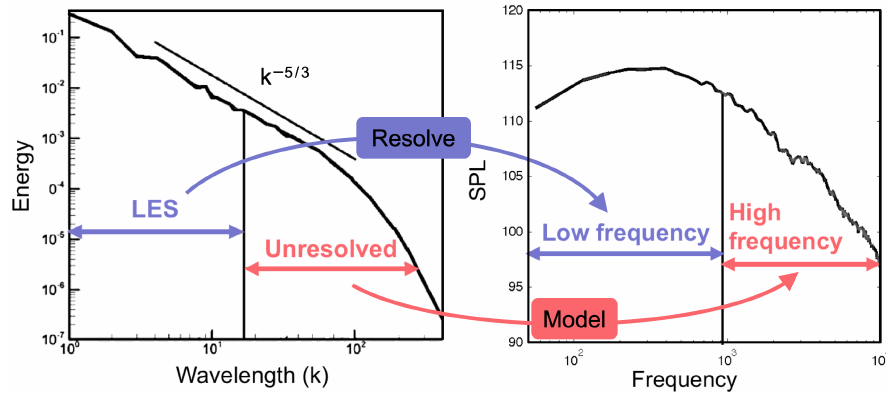
Figure 1. Representation of Resolved and Modeled Turbulent Scales in the CLST